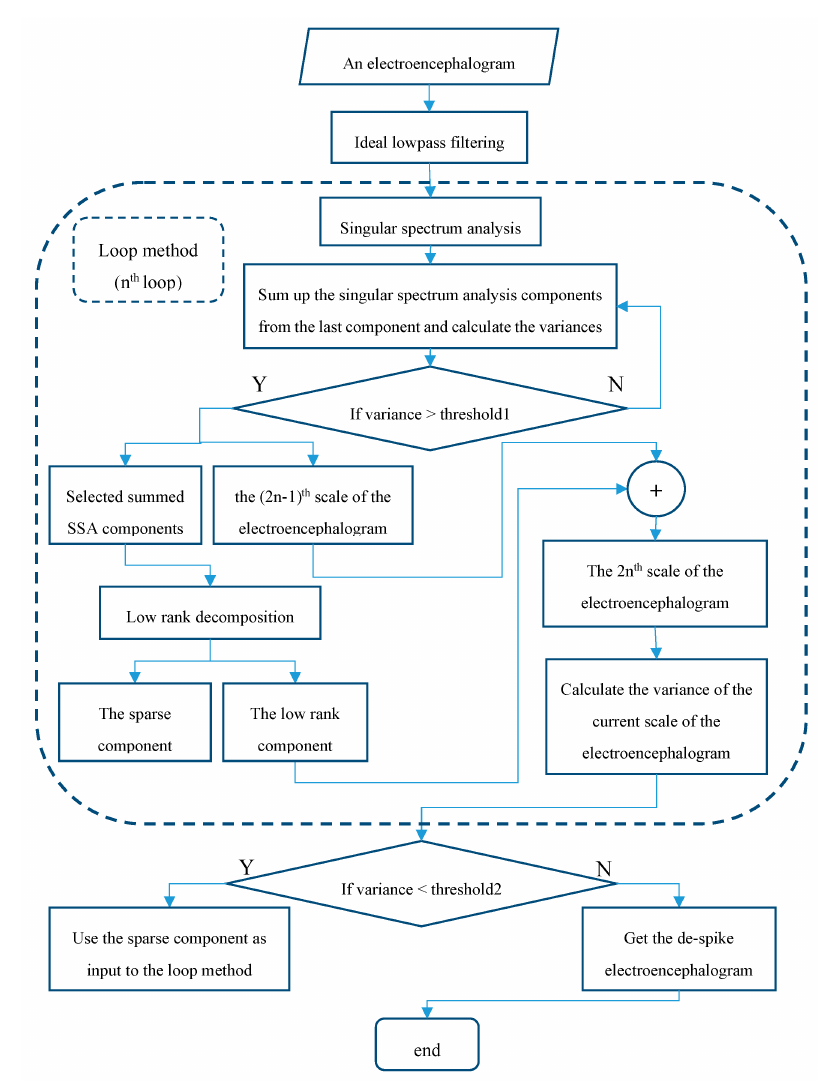
Figure 1. The flowchart of the proposed method.